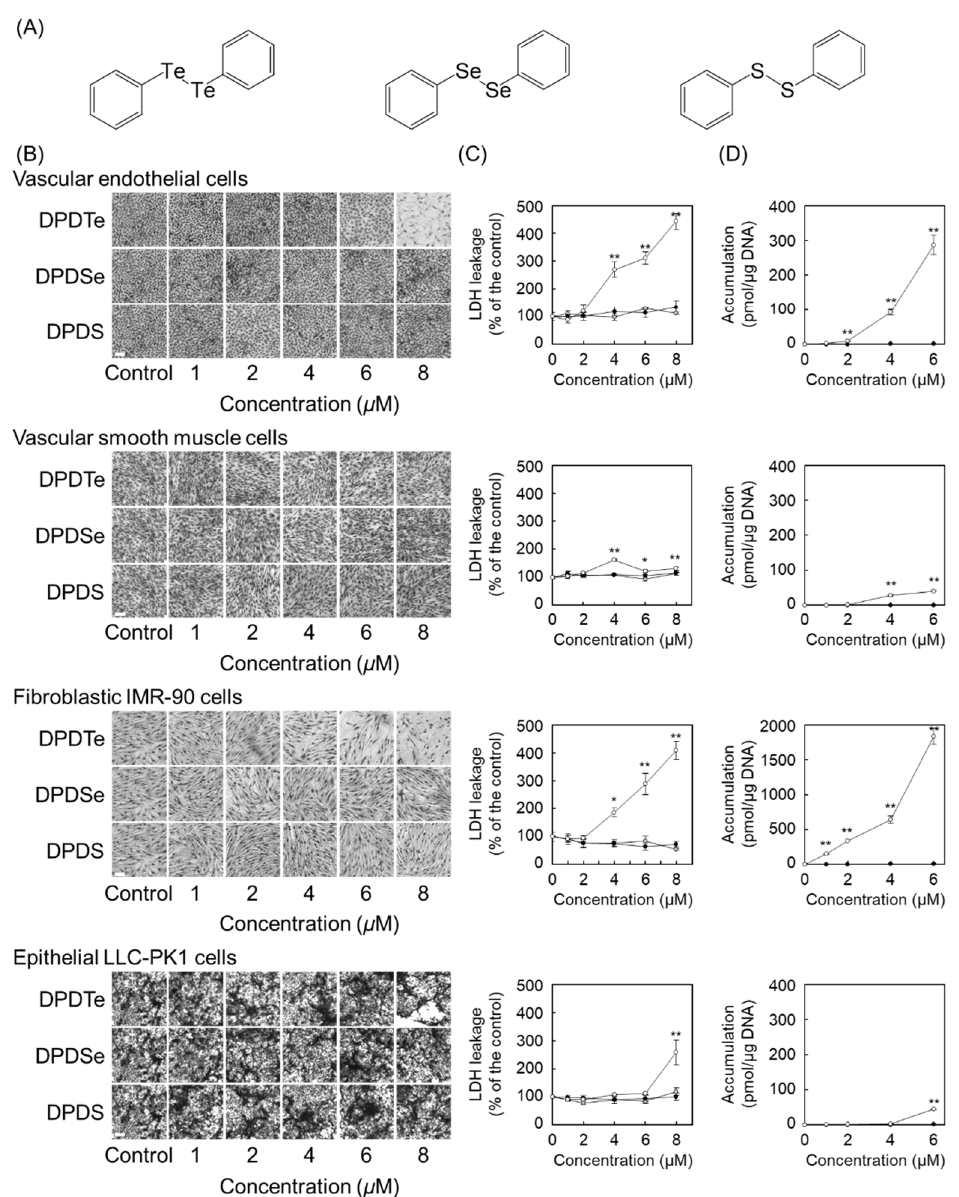
Figure 1. Cytotoxicity and intracellular accumulation of diphenyl ditelluride (DPDTe), and compounds, in which tellurium in DPDTe was replaced by selenium and sulfur atoms (DPDSe and DPDS). Vascular endothelial cells, vascular smooth muscle cells, fibroblastic IMR-90 cells, and epithelial LLC-PK1 cells were treated with DPDTe, DPDSe, or DPDS (1, 2, 4, 6, or 8 µ M) for 24 h. ( A ) Structure of DPDTe (left), DPDSe (middle), and DPDS (right). ( B ) Morphological observation (bar = 50 µ m) and ( C ) lactate dehydrogenase (LDH) leakage from the cells treated with DPDTe (white), DPDSe (black), or DPDS (gray). ( D ) Intracellular accumulation of DPDTe (white) and DPDSe (black). Values are expressed as the mean ± standard error of three replicates. * p < 0.05, ** p < 0.01 compared with the corresponding control.